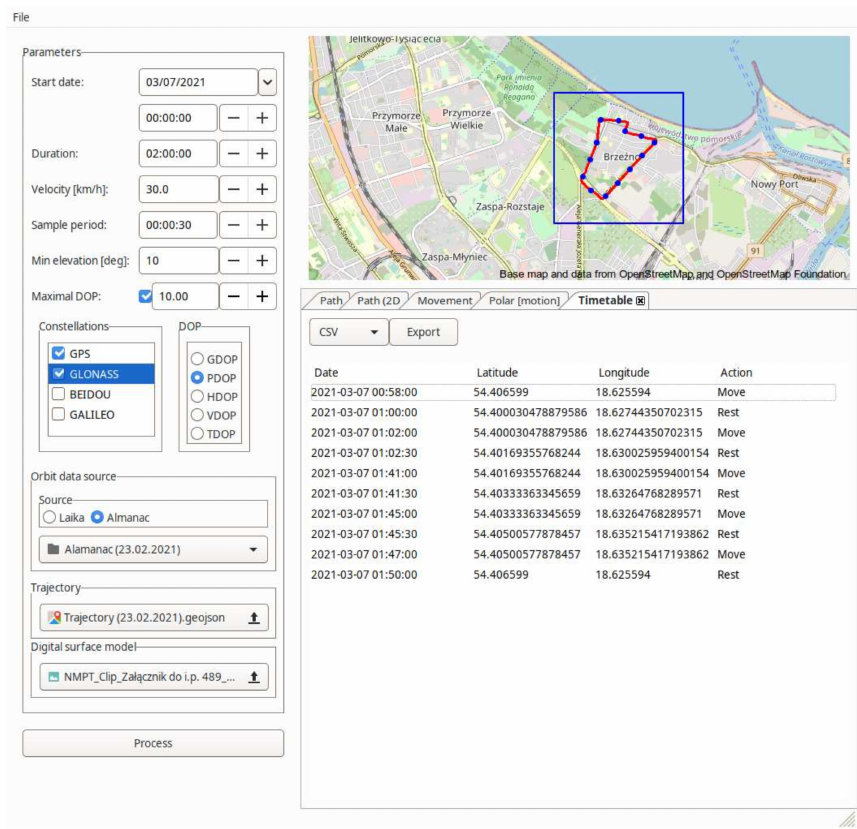
Figure 12. Window of the software for the planning of a linear object GNSS measurement campaign for the optimum variant during the performance of the second test series.